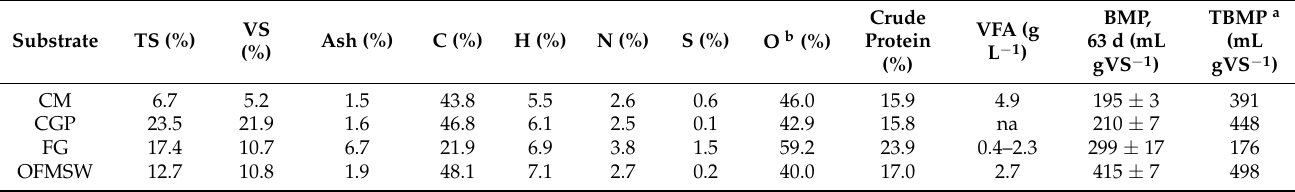
a TBMP is the theoretical maximum BMP based on the CHNS values. The TBMP is calculated by Buswell and Boyle’s equation [22].